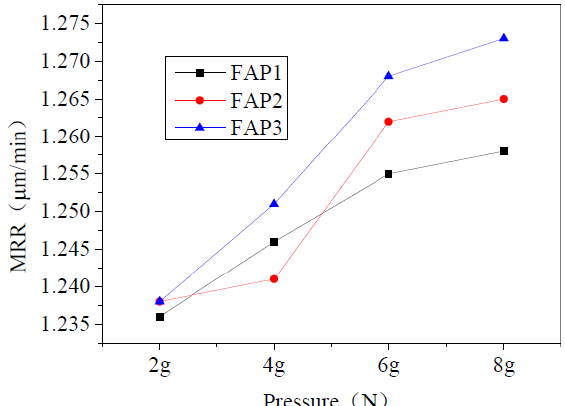
Figure 15. MRR vs. pressure.